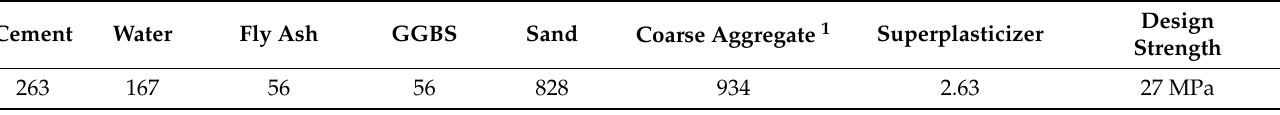
Table 5. Mix composition and design strength of ready-mixed concrete (unit: kg/m 3 ).